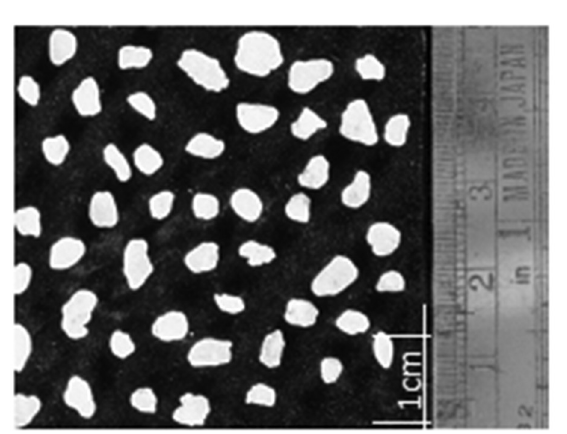
Figura 3. Amostra de areia das frações grossas com a escala auxiliar para referência do tamanho da imagem.